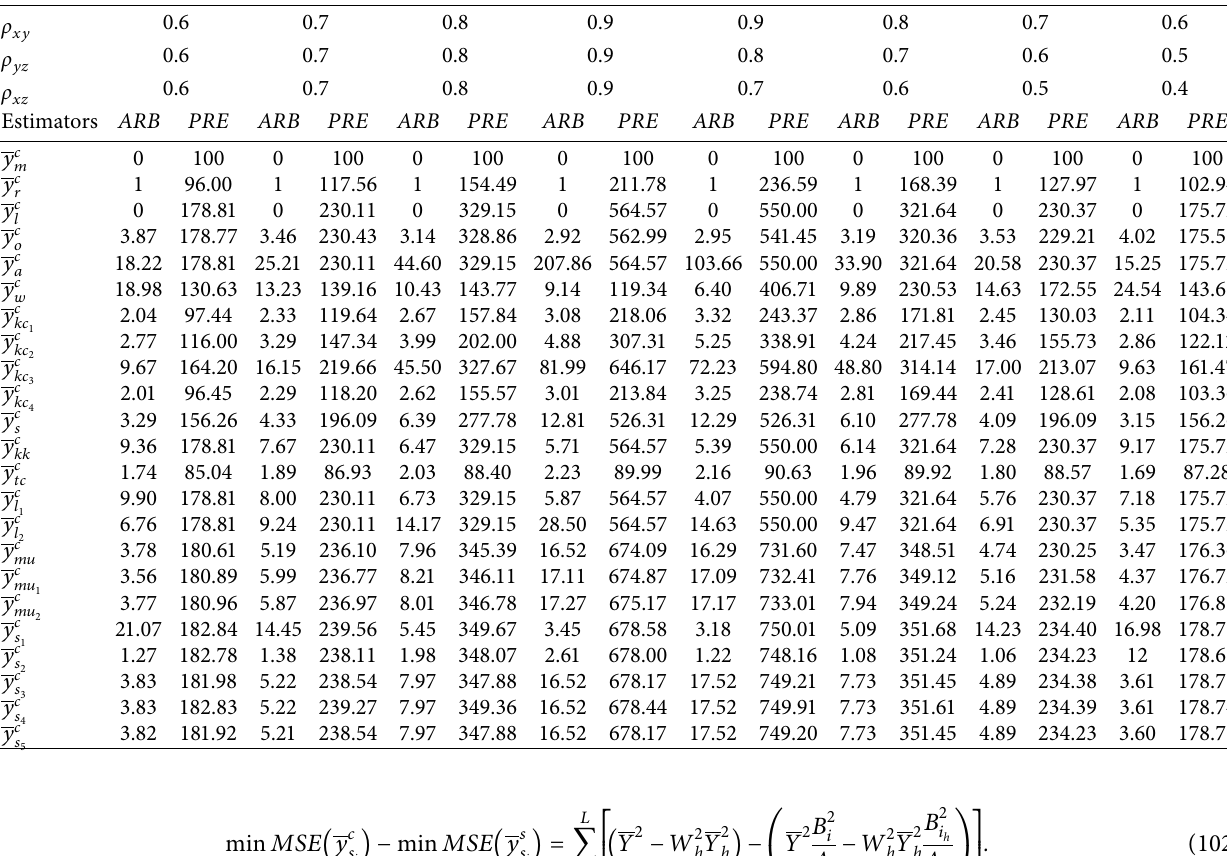
Table 1: ARB and PRE of different combined